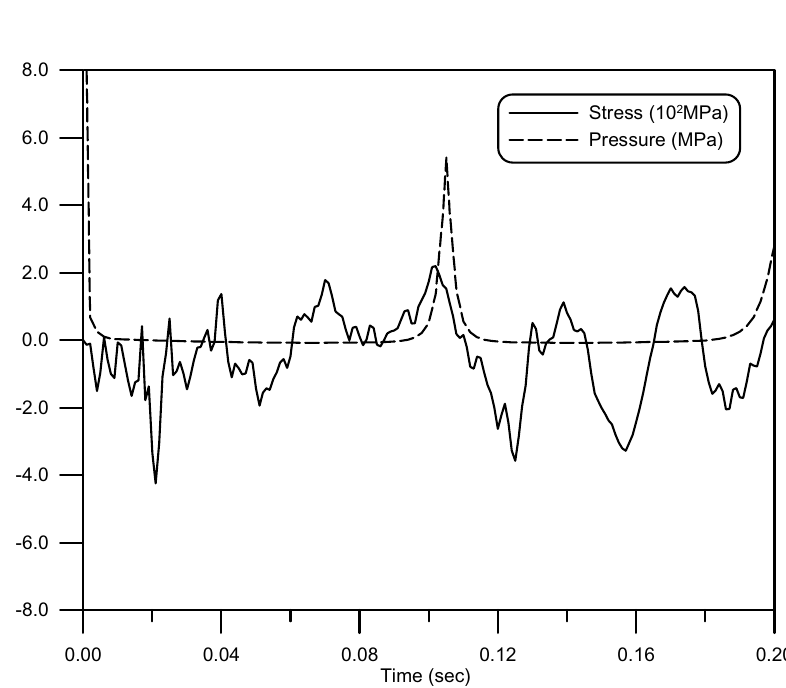
Fig. 9. Pressure and stress at the standoff